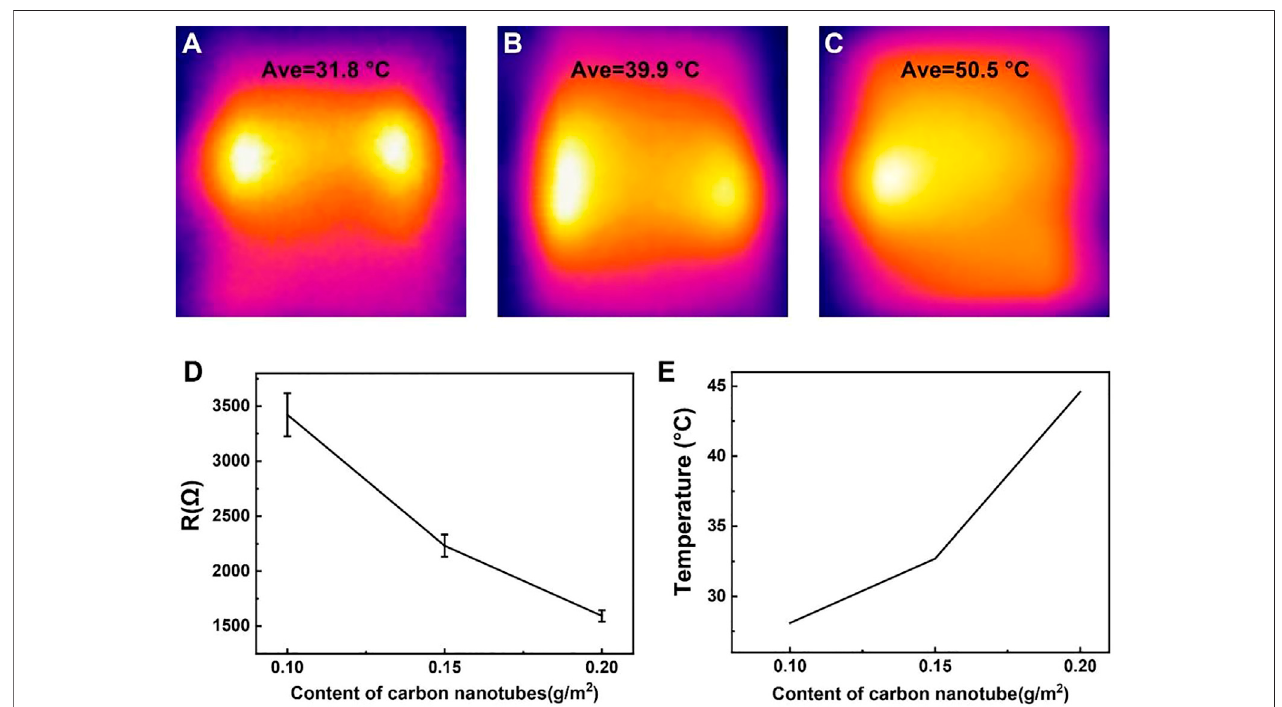
FIGURE6| Theinfrared thermalimages: (A) FTFH-0.1, (B) FTFH-0.15, and (C) FTFH-0.2, (D) theresistance ofFTFH withthecontentofcarbon nanotube ranging from 0.1 g/m 2 to 0.2 g/m 2 (E) the generated temperature of the FTFH with the content of carbon nanotubes ranging from 0.1 g/m 2 to 0.2 g/m 2 .